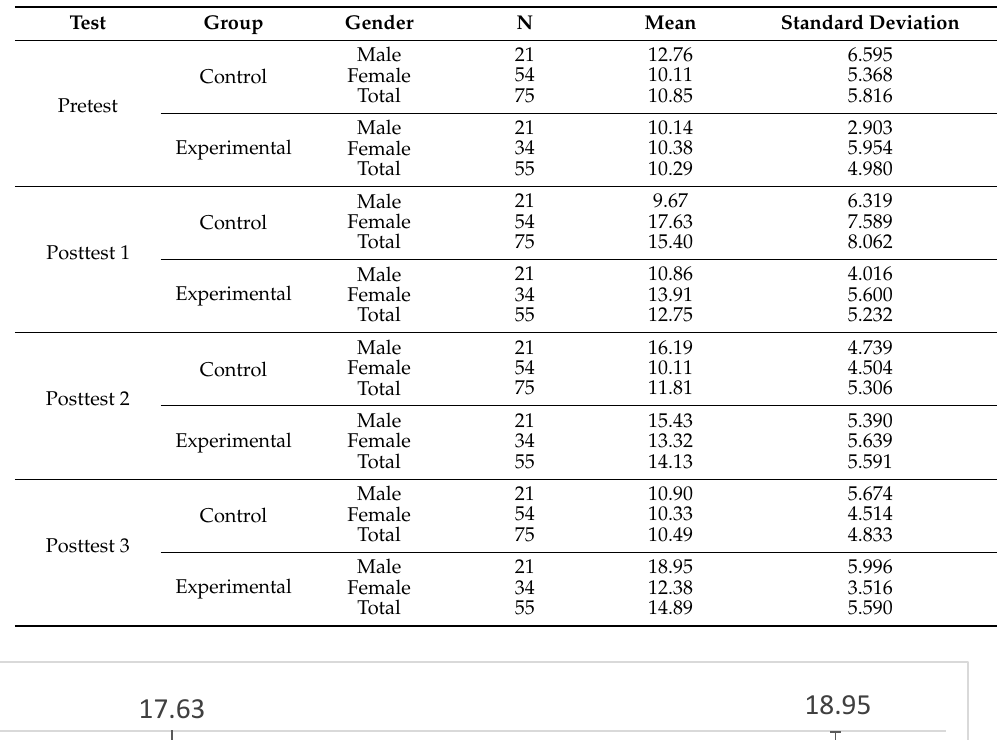
Table 2. Descriptive Statistics for all Groups (N = 130).